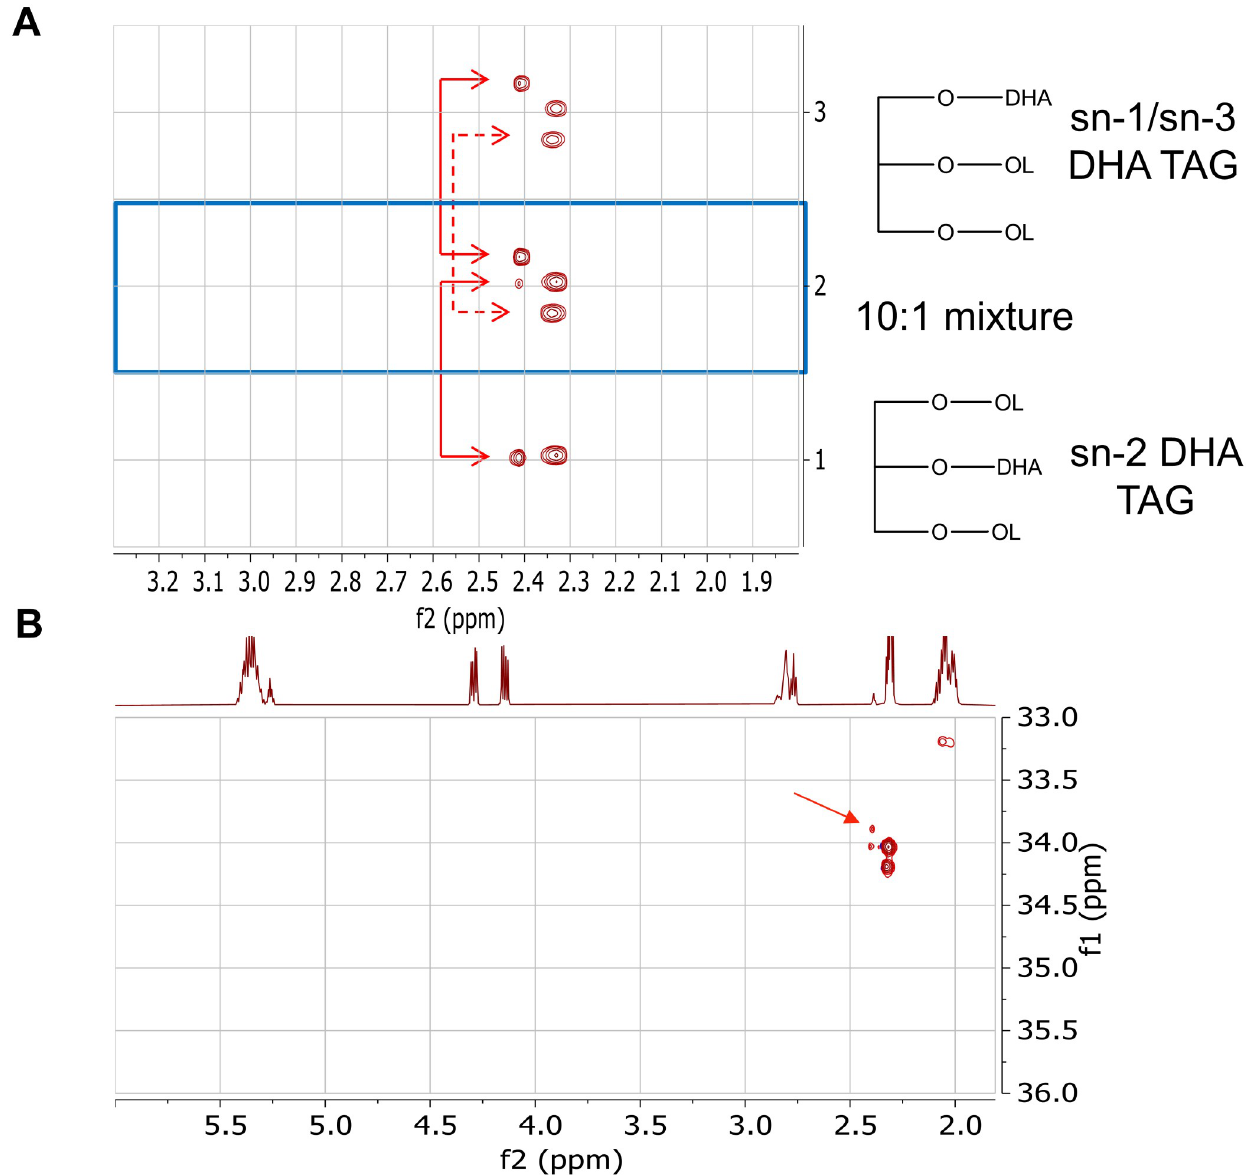
Fig 3. Band-selective HSQC NMR spectra. (A) Comparison of expanded HSQC spectra of pure standards, sn -1/ sn -3 DHA TAG and sn-2 DHA TAG. Scale for 13 C range: 33.6–34.5 ppm (B) Example of HSQC spectra from an Arabidopsis oil sample. The DHA gives rise to the small peaks (marked with an arrow) seen just down field (to the left) of signals from other fatty acids in the sample. The upper peak is that of the methylene group attached to sn -1/ sn -3 on glycerol, whereas the lower peak arises from the methylene attached to sn -2 of glycerol. Relative peak volumes give the relative amounts of each.